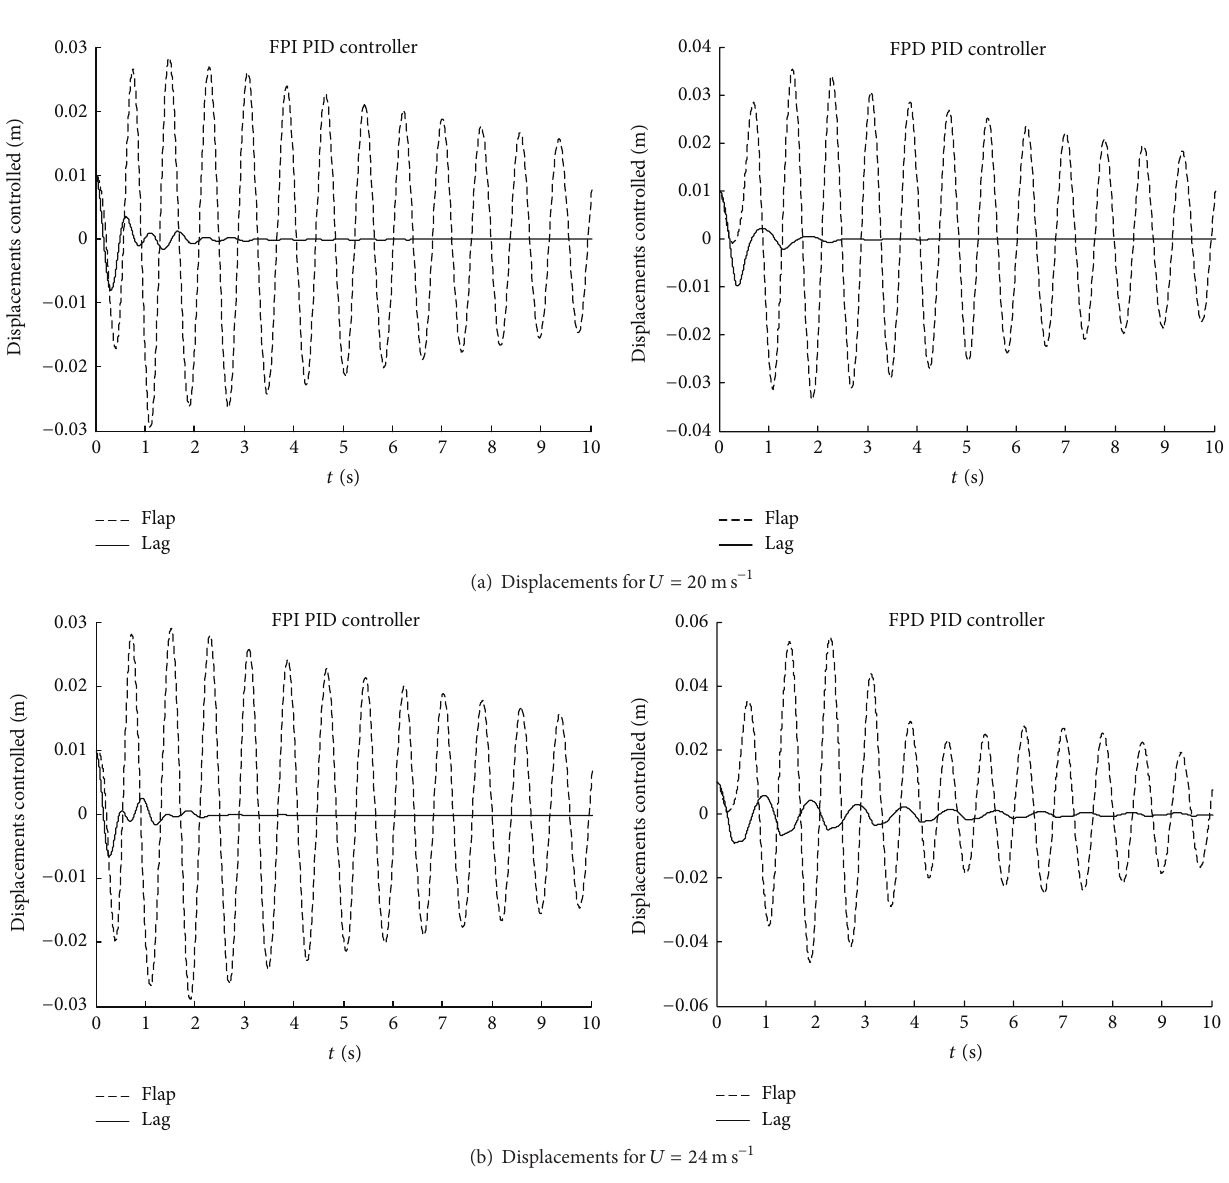
Figure 11: Flap and lag displacements of Case three for different fuzzy